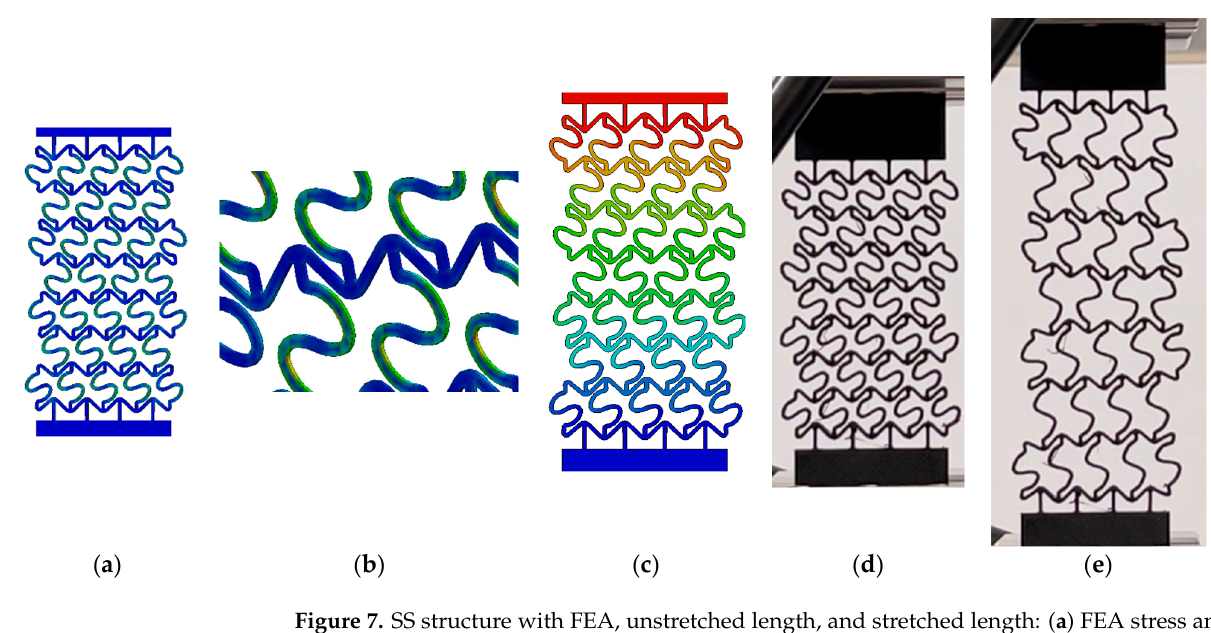
Figure 7. SS structure with FEA, unstretched length, and stretched length: ( a ) FEA stress analysis, ( b ) FEA close-up for stress concentration, ( c ) FEA displacement, ( d ) printed structure, ( e ) stretched printed structure.